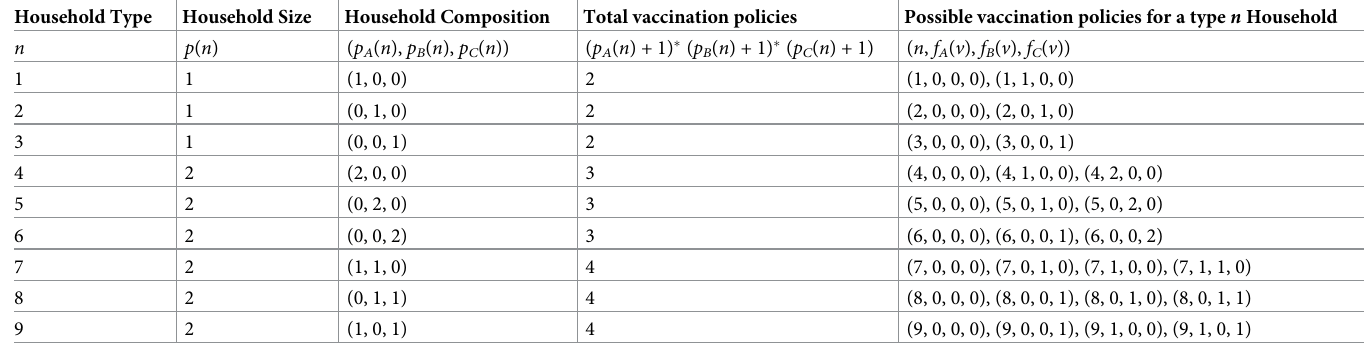
Table 2. Example household types and vaccination policies under heterogeneous population for p ( n ) = 1 and p ( n ) =